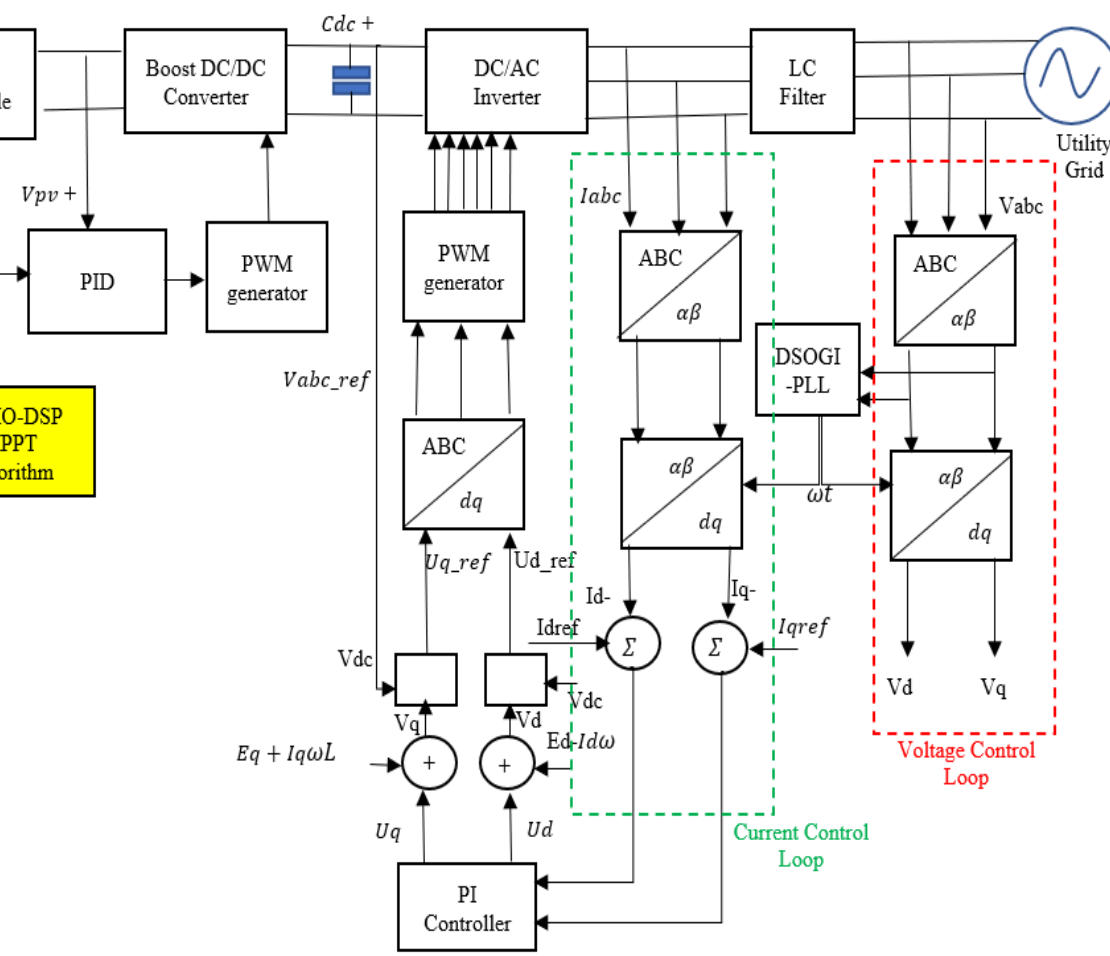
Figure 1. The proposed grid-integrated PV system power stage schematic with the MPPT and inverter control loop system and DSOGI-PLL algorithms.